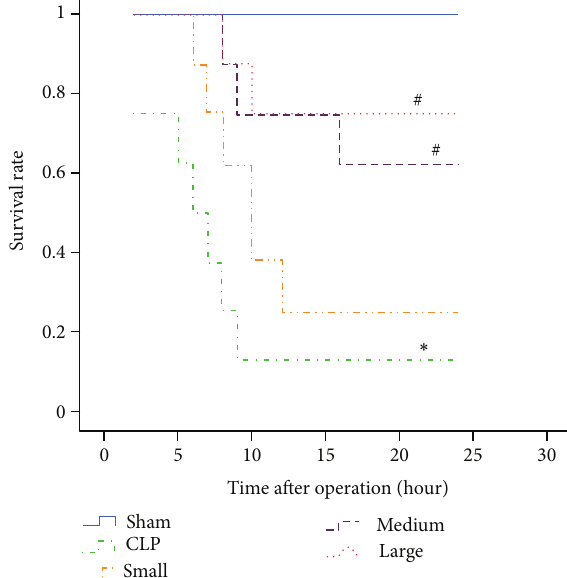
Figure 1: Effect of dexmedetomidine on survival curves of septic rats induced by CLP. Sham: sham operation group; CLP: cecal ligation and puncture operation group; Small: 5 𝜇 g/kg dexmedeto- midinetreatment group; Medium: 10 𝜇 g/kg dexmedetomidine treat- ment group; Large: 20 𝜇 g/kg dexmedetomidine treatment group. 𝑛 = 8 . The survival rate at 24h after operation was analyzed. ∗ 𝑃 < 0.01 , versus sham group; # 𝑃 < 0.01 , versus CLP